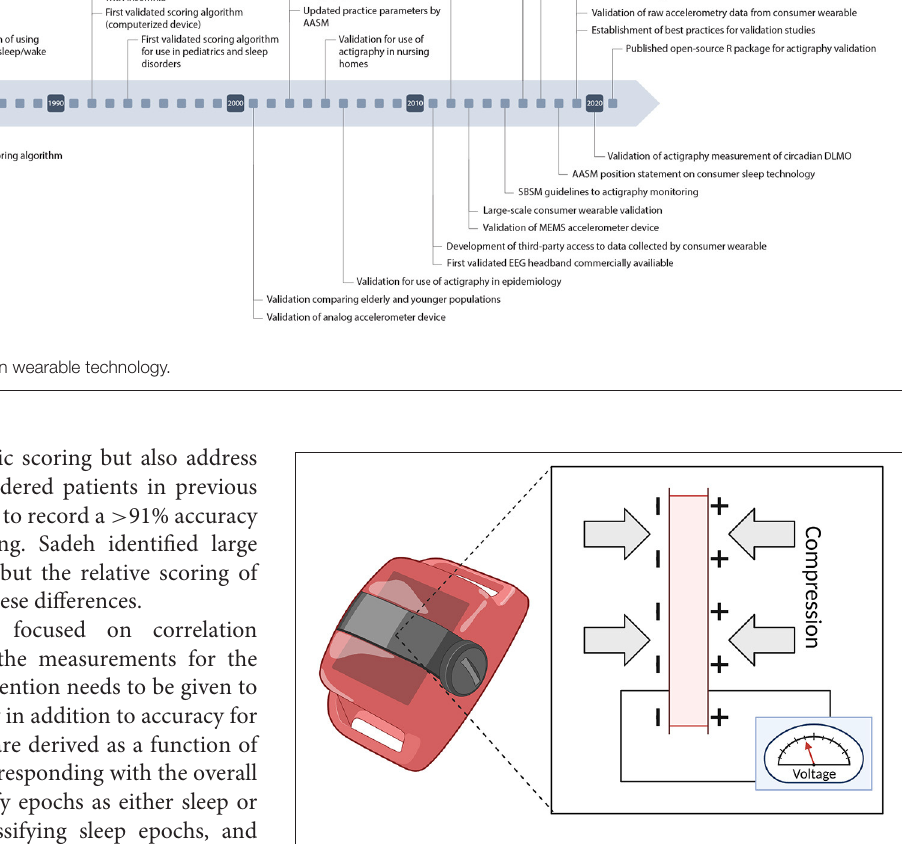
FIGURE 2 | Schematic of Piezoelectric